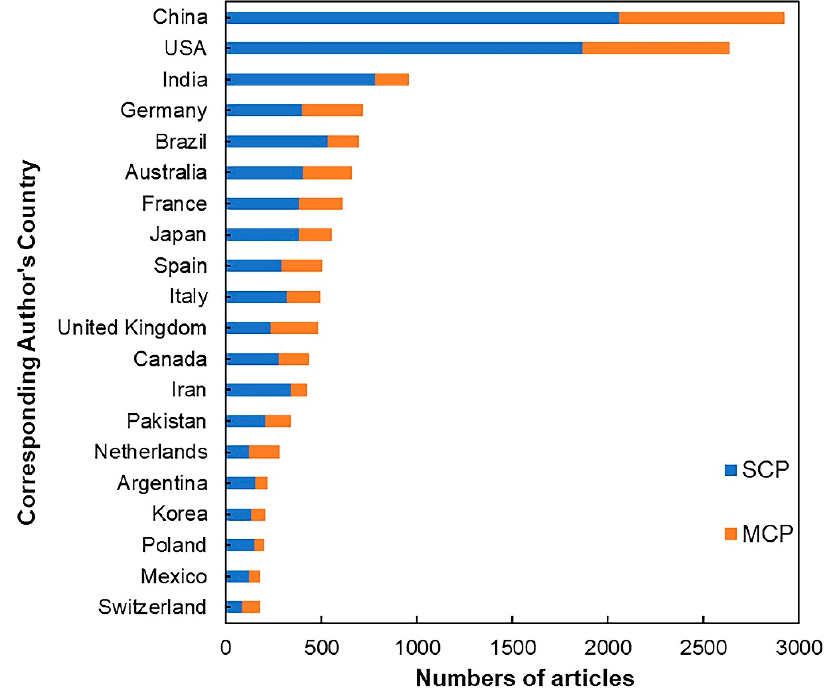
Figure 3 . The top 20 corresponding author’s countries by the number of articles published from 2000 to 2021. SCP: Single Country Publications; MCP: Multiple Country Publications .